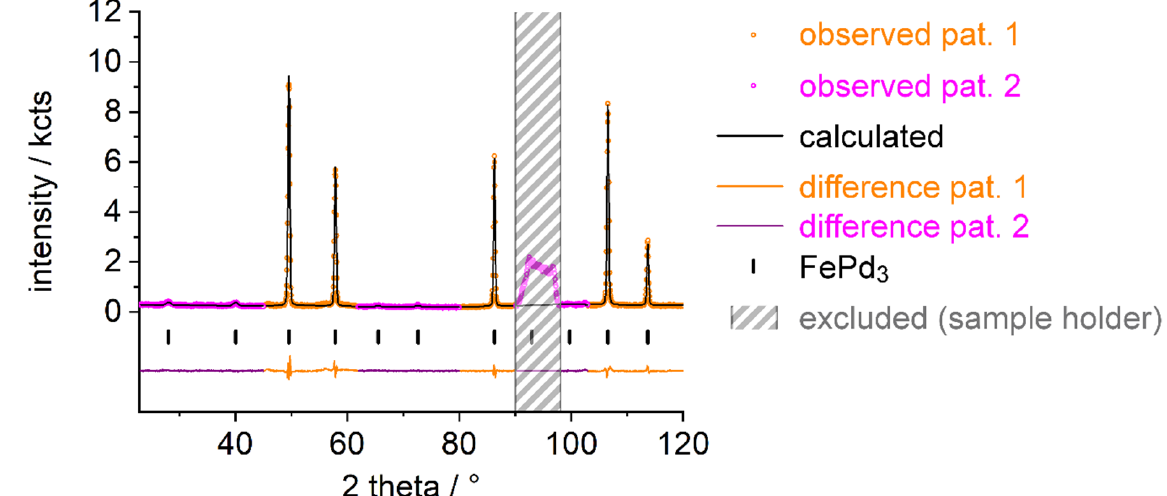
Figure A24. Rietveld refinement of the crystal structure of FePd 3 D 0.057(9) (for details, see twelfth row in Tables A8 and A9) based on neutron powder diffraction data (NUMOR 131833 [21], λ = 186.80(2) pm, D20 ILL, Grenoble) in a single-crystal sapphire cell at 473(2) K and 8.25(1) MPa deuterium pressure using FullProf [24].